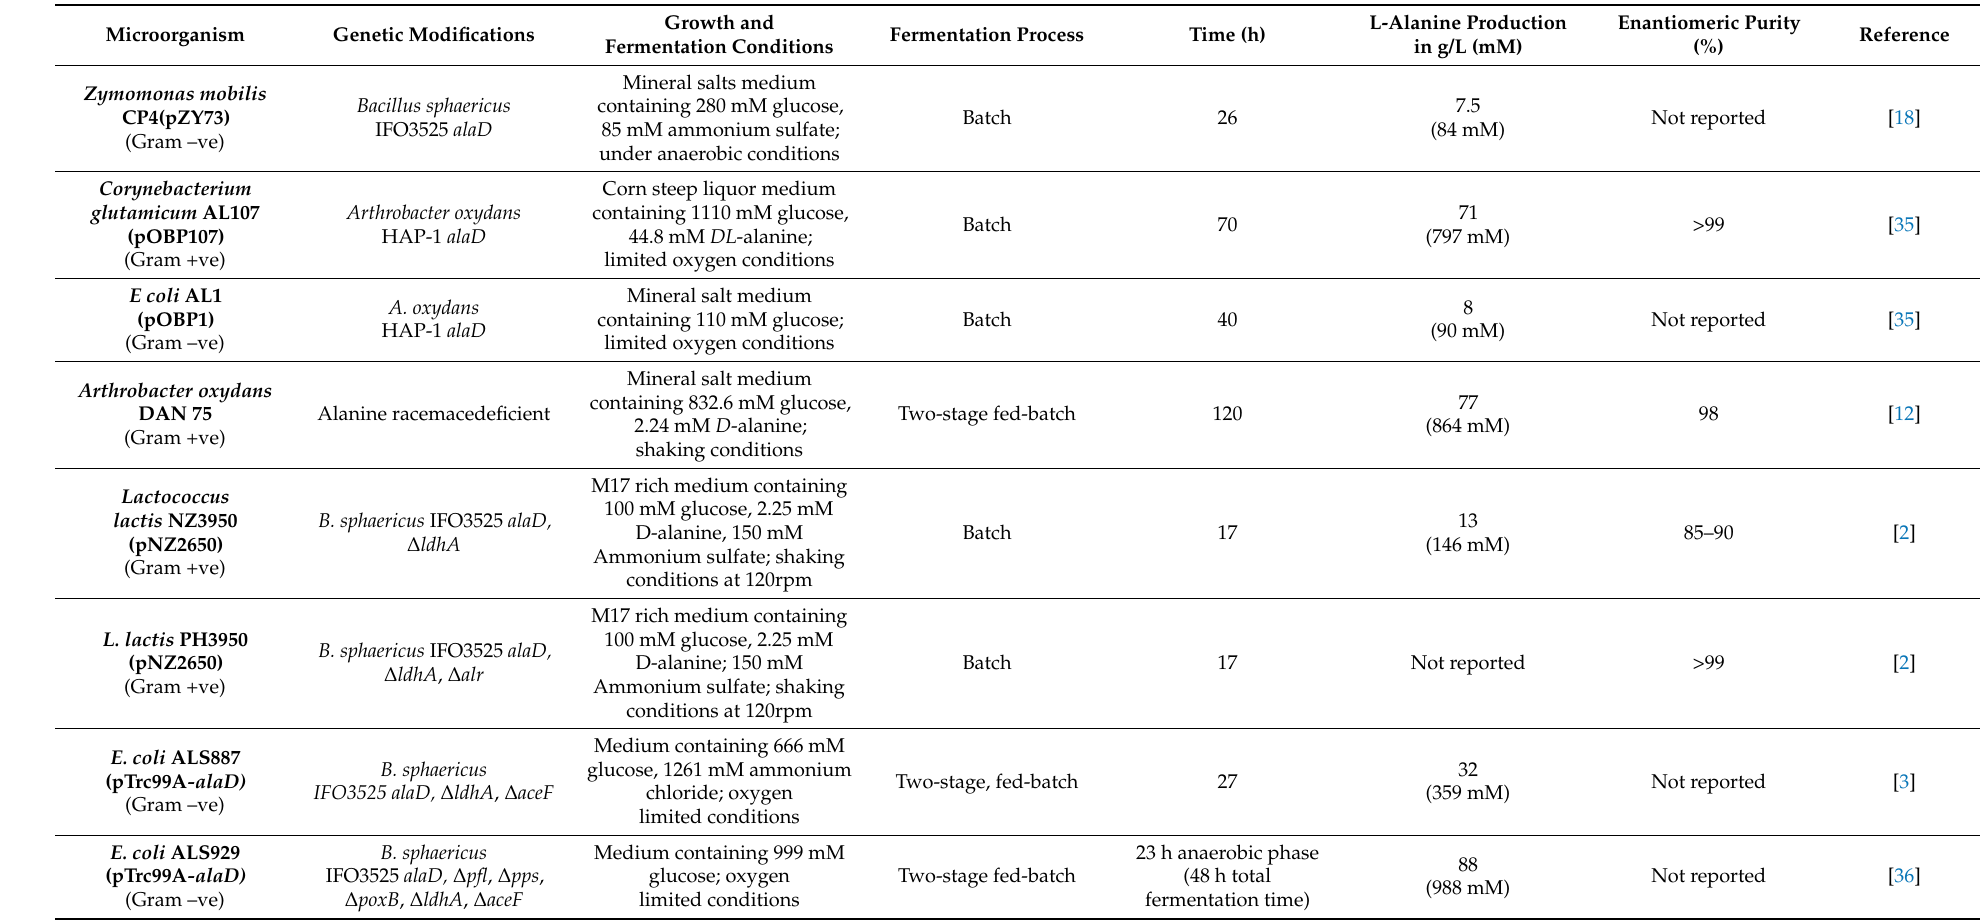
Table 1. Comparative account of L-alanine production using recombinant microbial